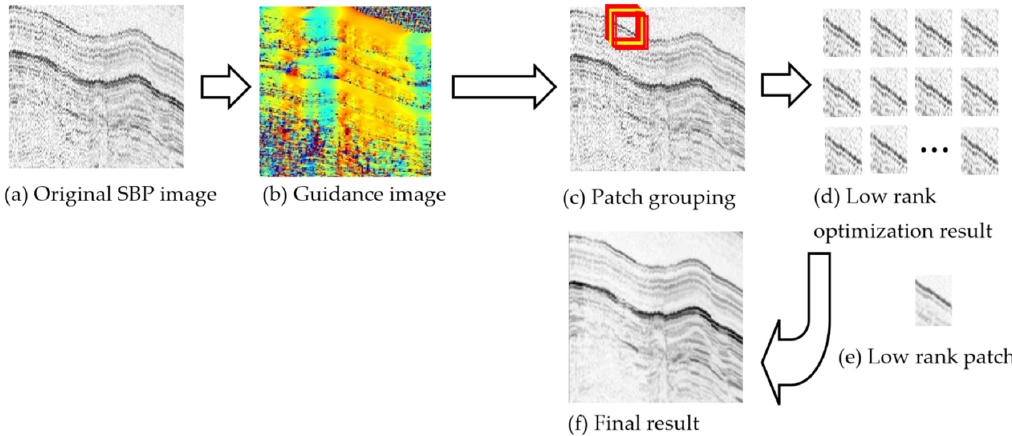
Figure 2. An overview of the proposed filtering framework. ( a ) is the original SBP image. First, the guidance image ( b ) is computed based on ( a ) to help the selection of similar patches. Then, after patch grouping (rectangles in ( c ) represent patches) and low-rank optimization (( d ) is the optimization diagram), the patches are refined, and the low-rank structures are recovered as shown in ( e ). Aggregating all of the low-rank patches, the final result ( f ) is obtained.